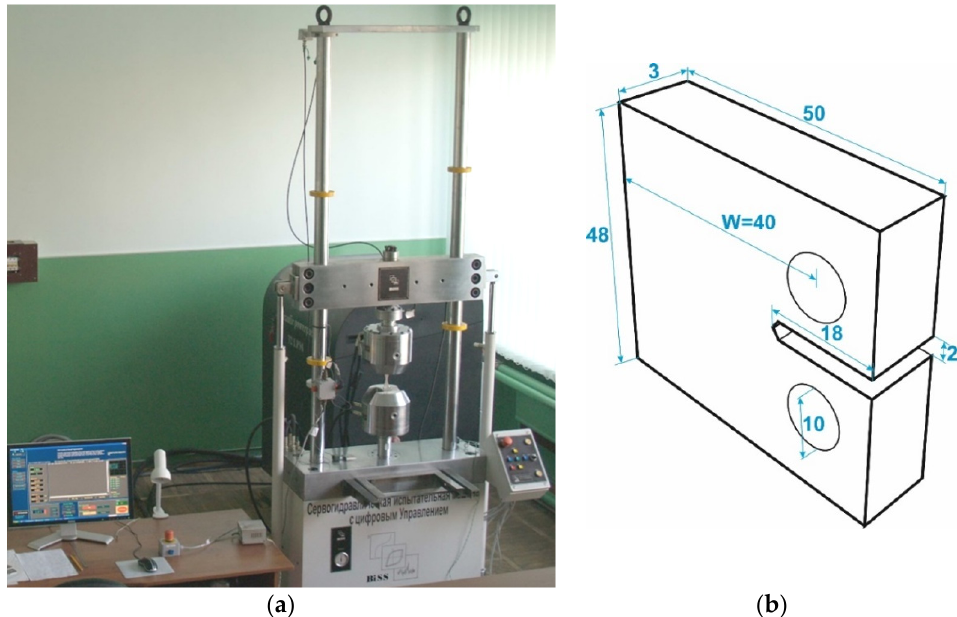
Figure 2. BISS servo-hydraulic testing machine ( a ) and a compact specimen ( b ) for FCG resistance tests. Dimensions are given in mm.